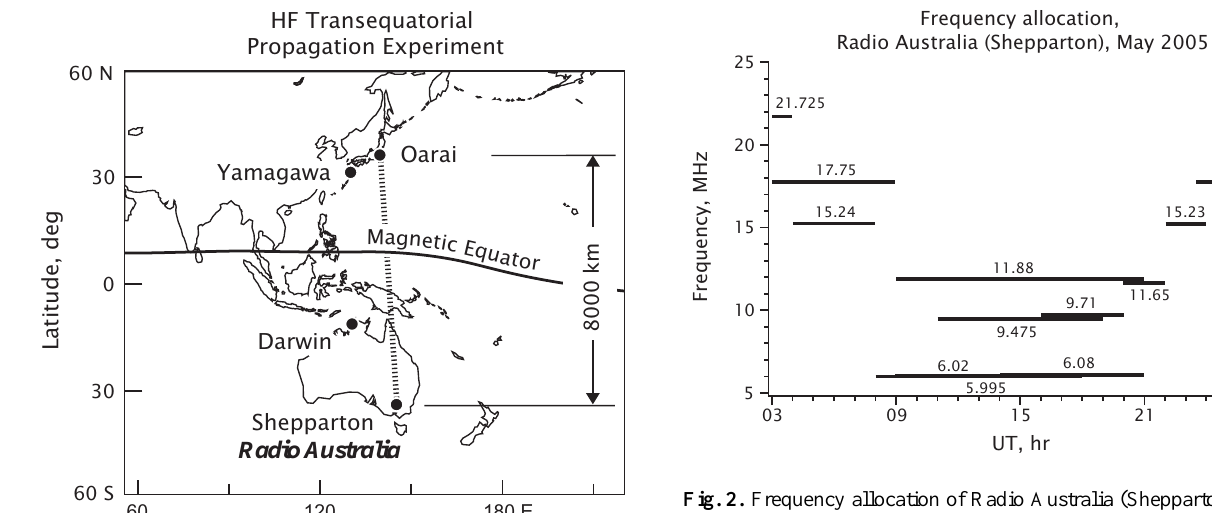
Fig. 2. Frequency allocation of Radio Australia (Shepparton) as of May 2005. The frequencies were subject to change depending on the season and solar